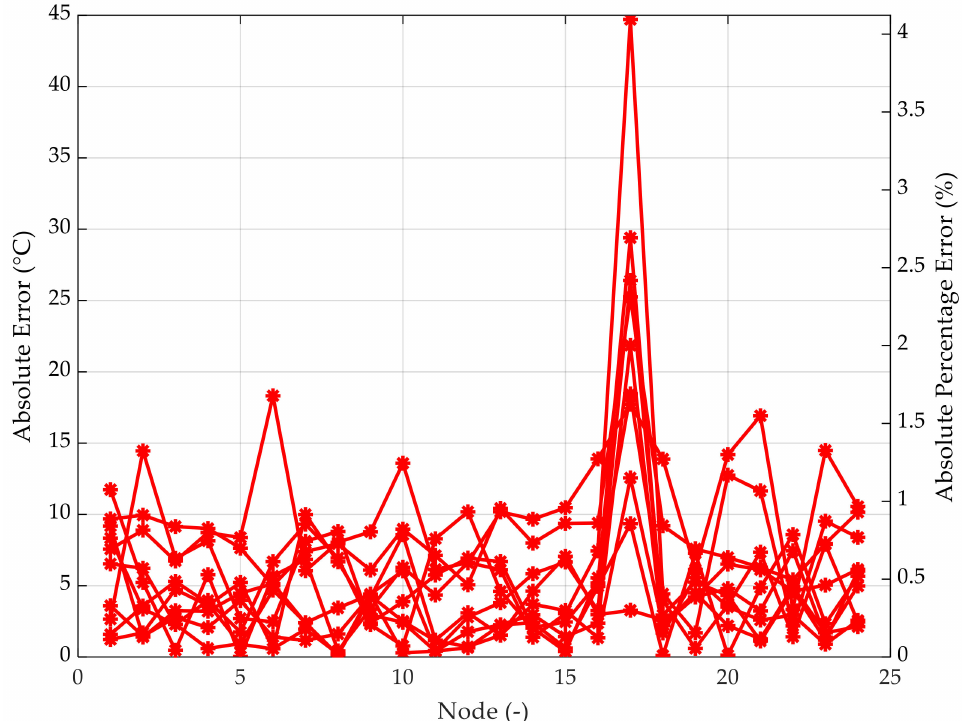
Figure 9. Computed absolute errors of the temperatures determined for each node for the specified operational regimes. The nodes in Figure 8 corresponds to the coordinates specified, where these specific points are directly shown on the surface of the turbine blade of the iSTC-21v jet